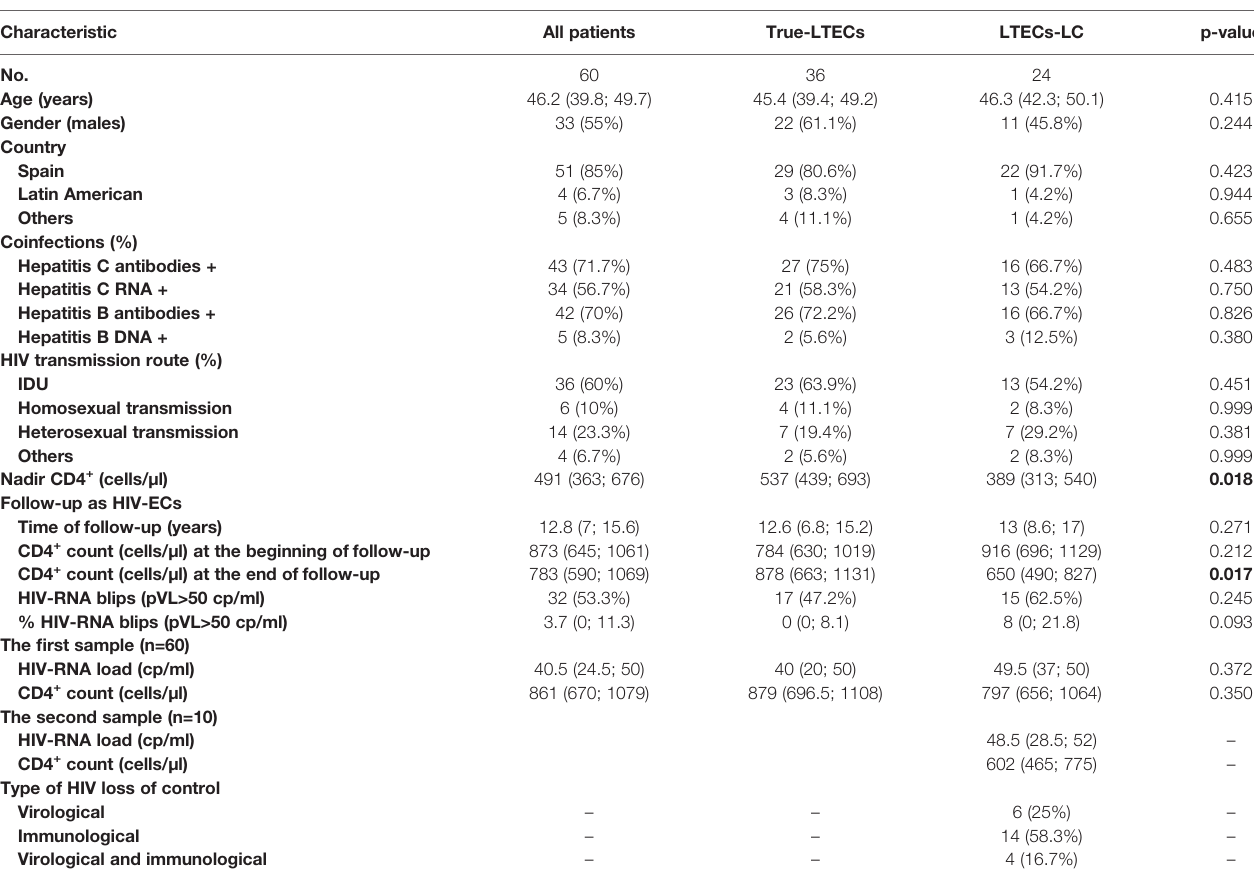
TABLE 1 | Characteristics of HIV-infected patients included in the study. Characteristic